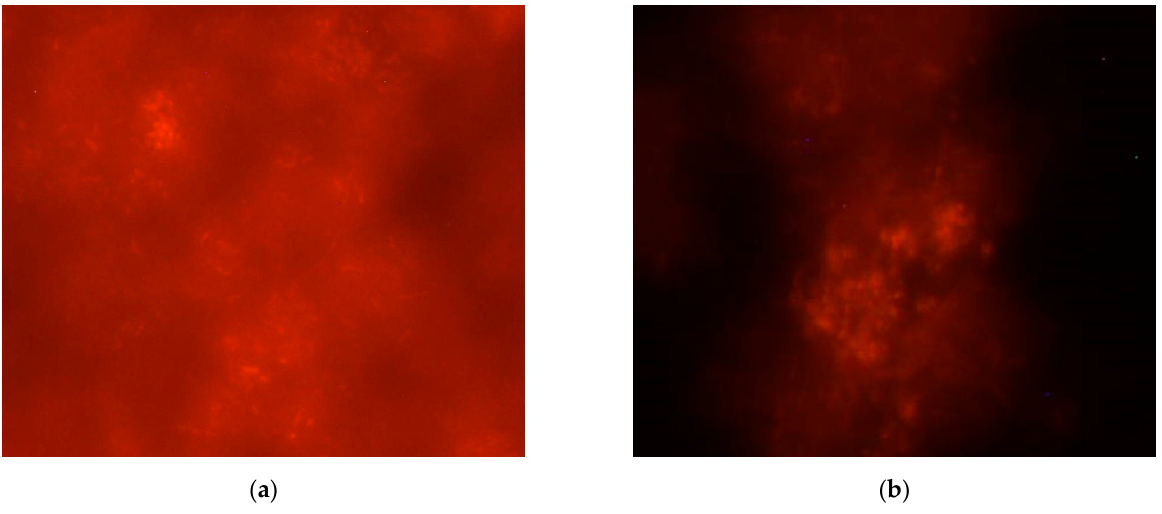
Figure 6. Micrographs of the sludge after fluorescent in situ hybridization, under red fluorescence. Red spots represent viable bacteria clusters (magnification: 1000×). Photos ( a , b ) representing the same sample at two different times.